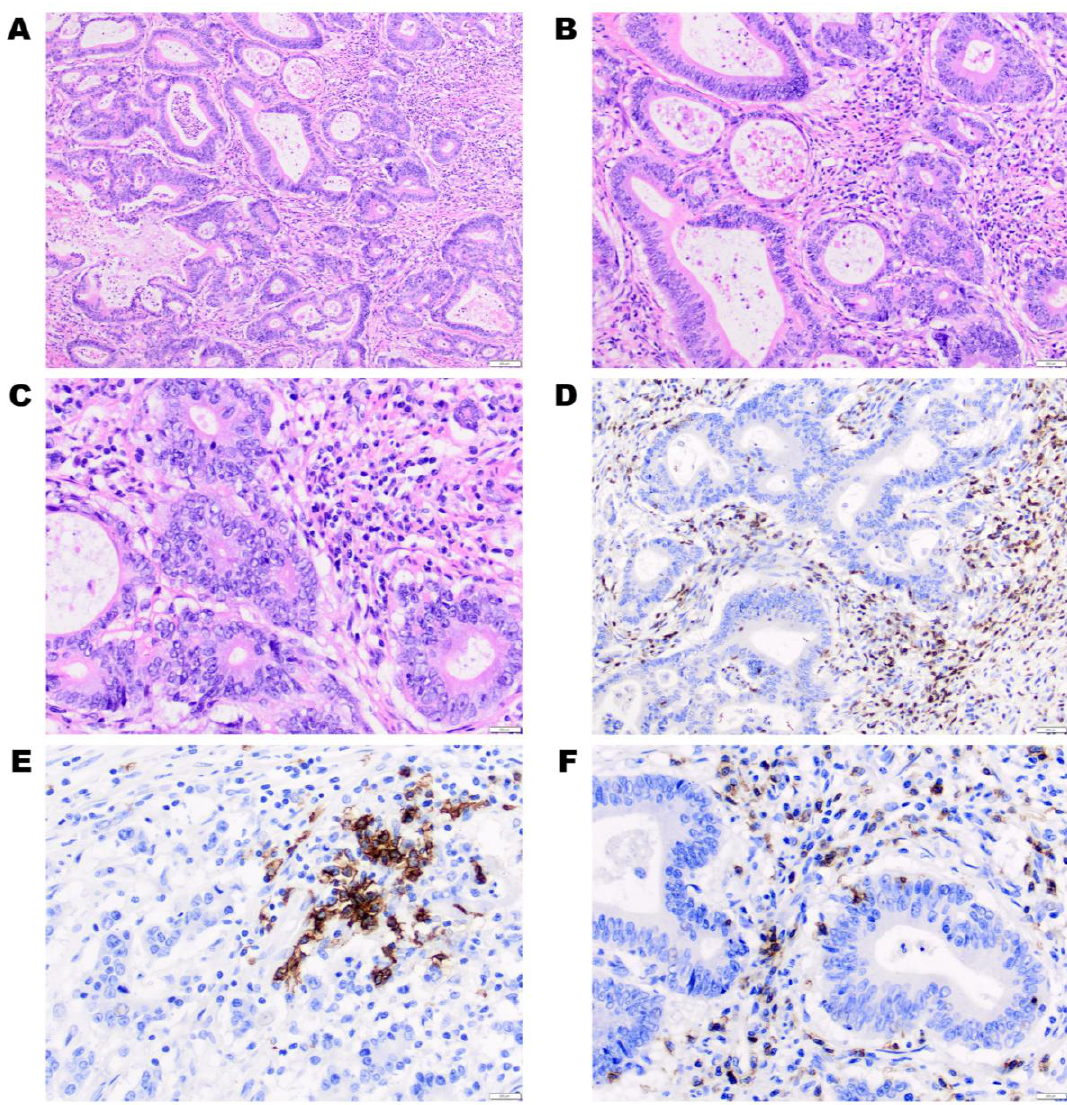
Figure 12. Histopathologic representation of tumor-infiltrating lymphocytes observed in the primary tumor. Hematoxylin and eosin stain, ( A ) ×100; ( B ) ×200; and ( C ) ×400. The following representative fields ( D – F ) show immunohistochemistry stain used to identify lymphocytes type. ( D ) The CD3+ indices presence of T lymphocytes, ×200. ( E ) The CD20+ marker indices presence of B lymphocytes, ×400; ( F ) the CD8+ marker indices presences of cytotoxic T lymphocytes, ×400. Downregulation of hsa-miR-190a-5p has been associated with fast-growing, clinically features, and potentially lethal cancer